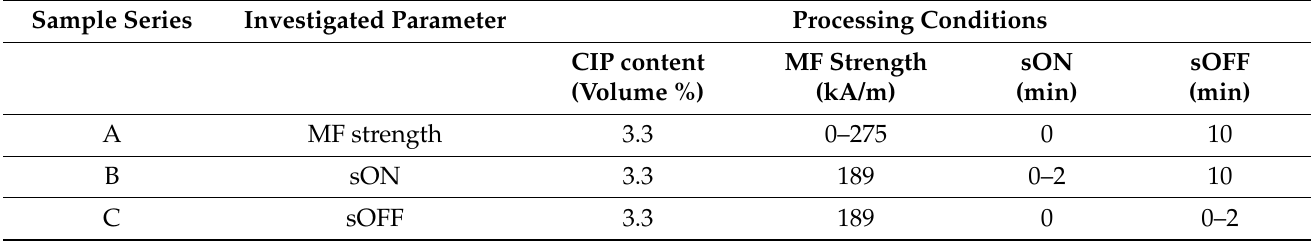
Table 1. Summary of the investigated foaming process parameters in the samples